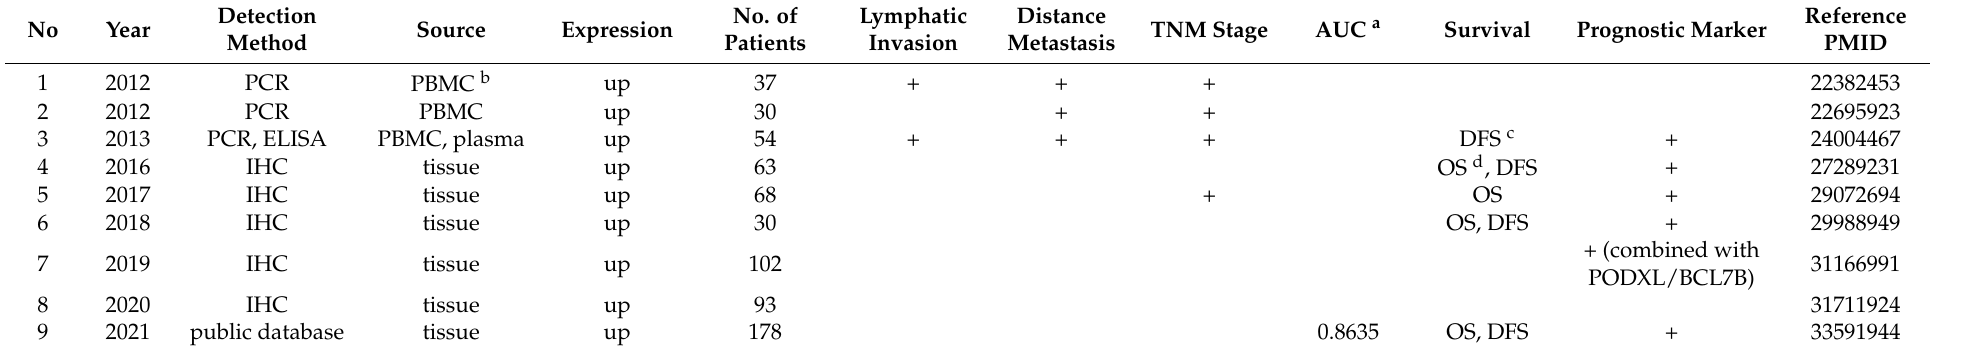
Table 2. Overview of the clinical significance of integrin β 1 in pancreatic